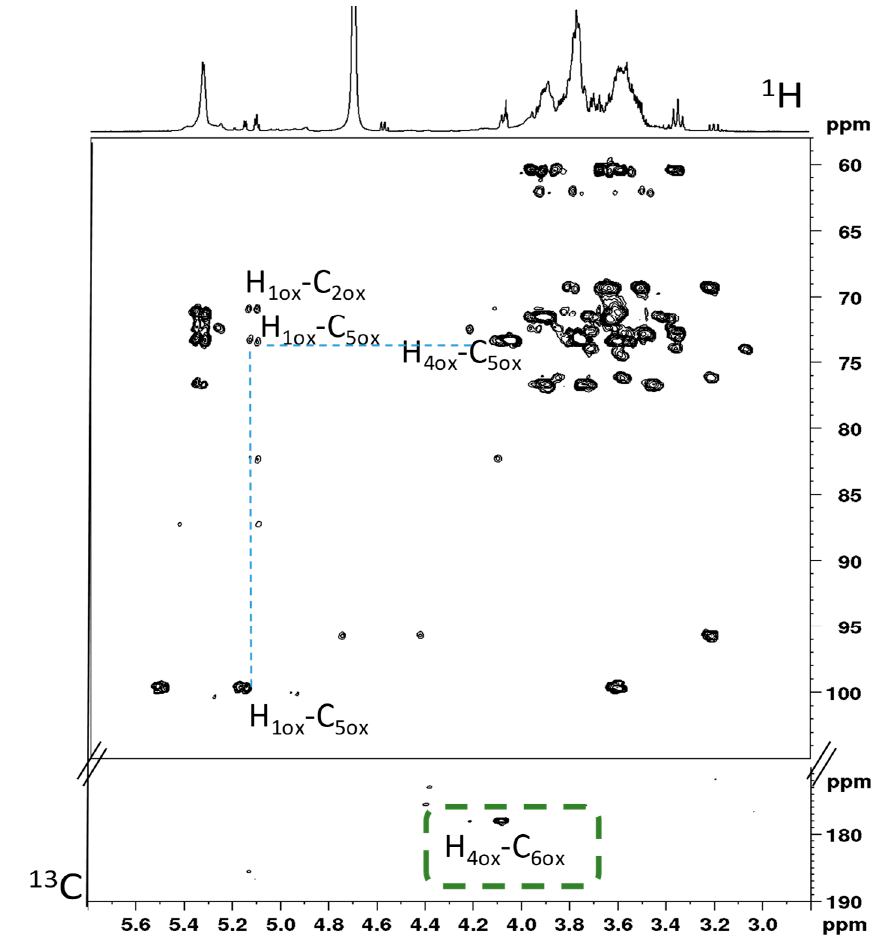
Figure 2. 1 H– 13 C HMBC spectrum of partially oxidized pea pod starch (PS) from sample C in D 2 O at 298 K. Some characteristic resonances are highlighted and refer to minor components from the oxidation process assigned with this technique.